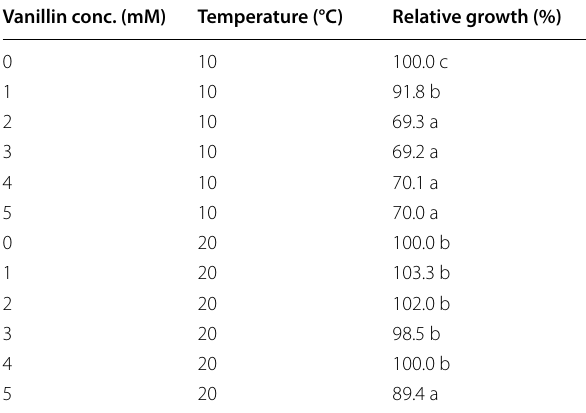
2.74 0.02) and = ± 2.03 0.04) = ±